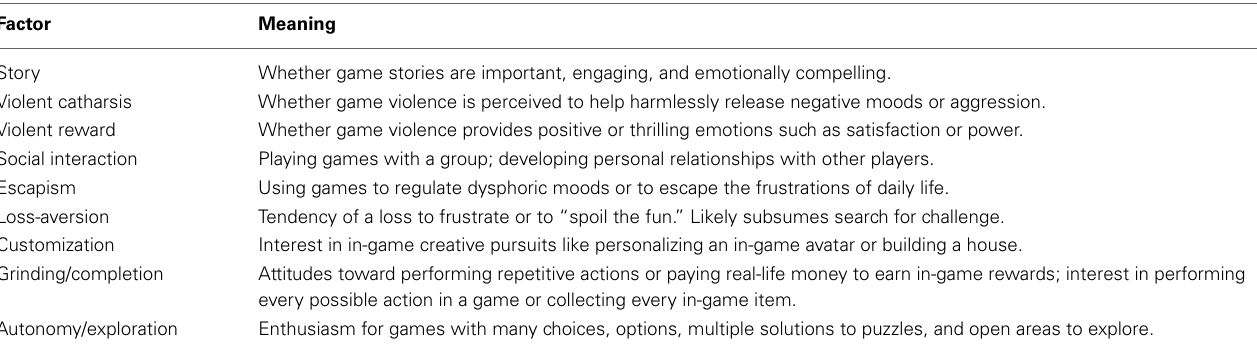
Table 1 | GAMES factors and their hypothesized